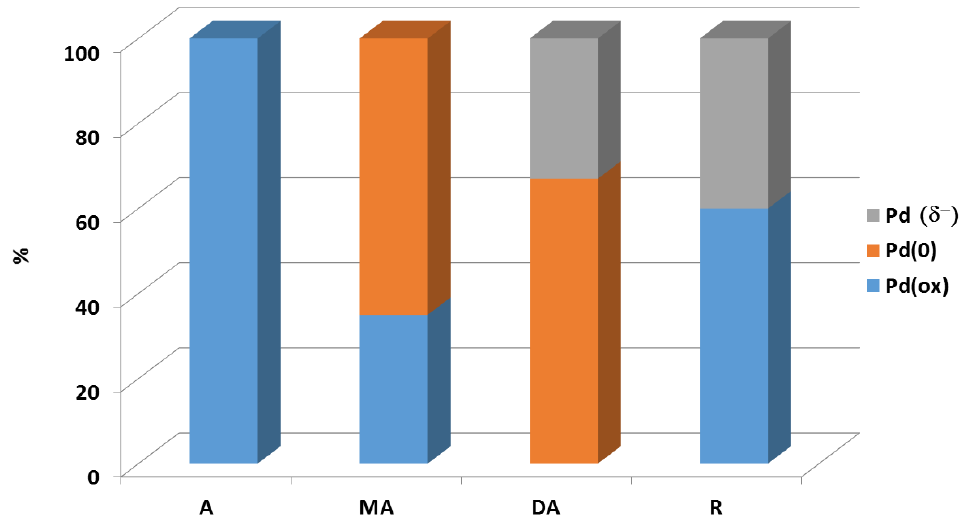
Figure 9. Different Pd species on the surface of 10% PdSb/TiO 2 catalyst at different stages of reaction (A: activated; MA: maximum active ( X = 68%, after 11 h operation); DA: deactivated ( X = 46%, 22 h); R: regenerated ( X = 68%)).